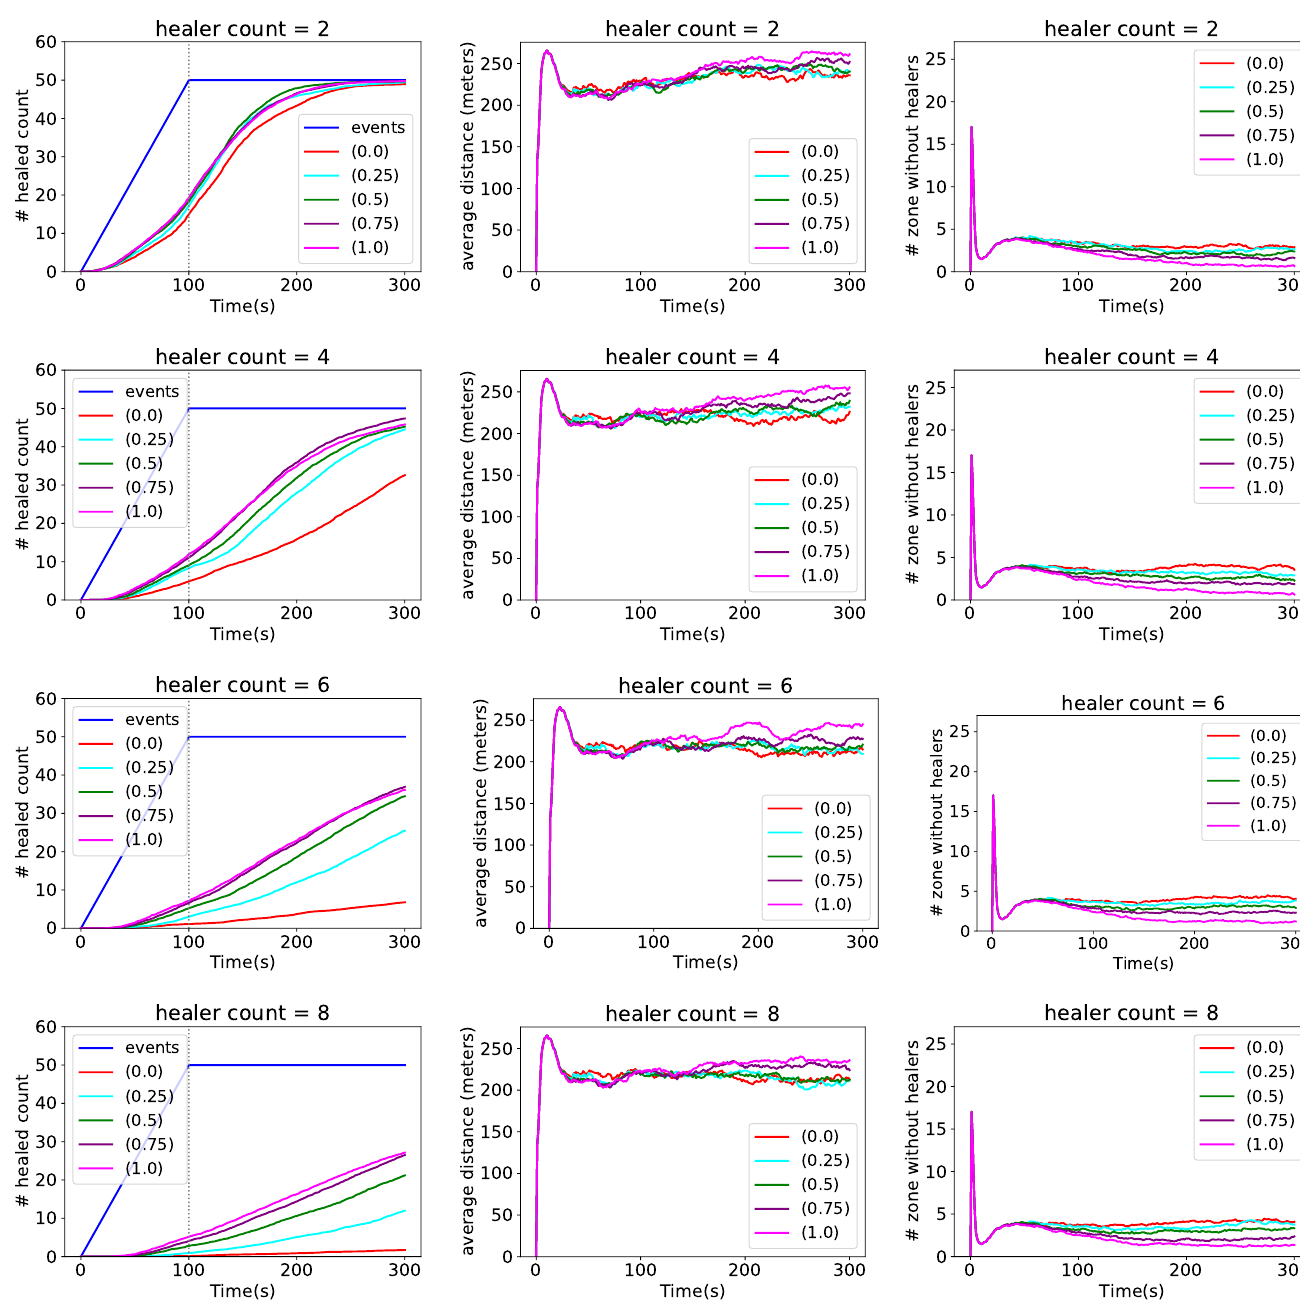
Figure 5. Experiment results. In each plot, the color identifies the p parameter. The first column shows how many animals are rescued during the simulation. The plots in the second column show the average distance from the leader. The plots in the last column point out how many zones have not enough healers to rescue an